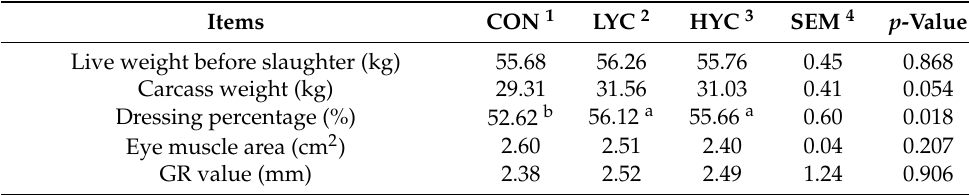
Table 7. Effect of dietary different supplemental levels of YC on carcass characteristics of fattening Hu sheep.